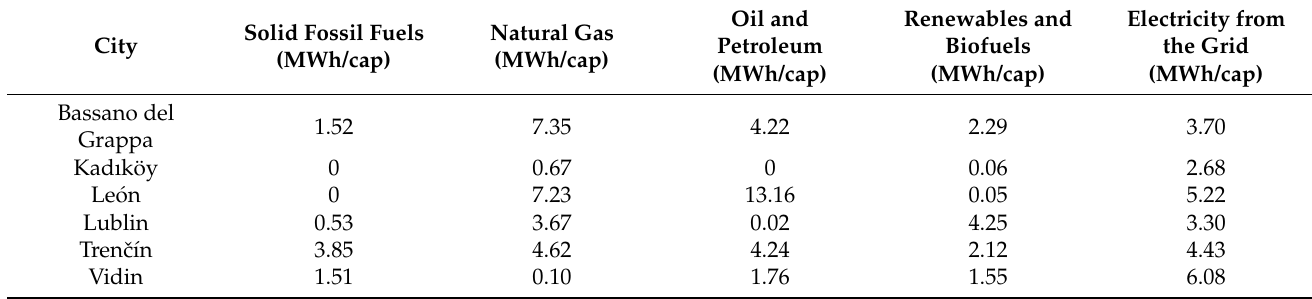
Table 15. Primary energy sources of the cities.